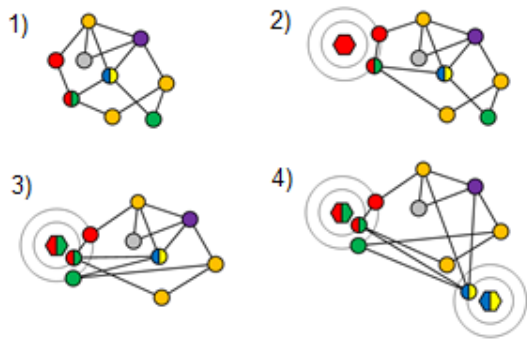
Fig. 3. Base scenarios for multi-attributed interaction of MFE.